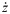
Diagrammatic representation of the four different behaviours, showing the measured outputs z˙ and γ˙.For the non-rotative behaviours (a,b) γ˙=0.